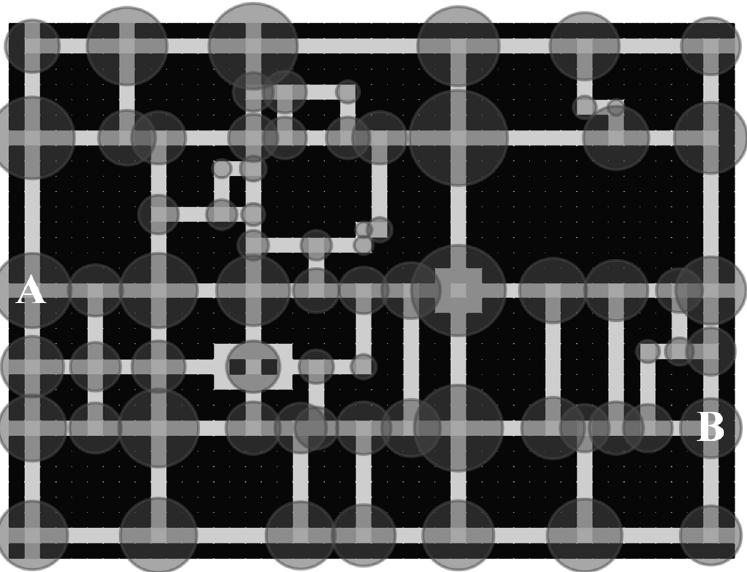
Figure 12. Evaluation results of the accessibility of each node.